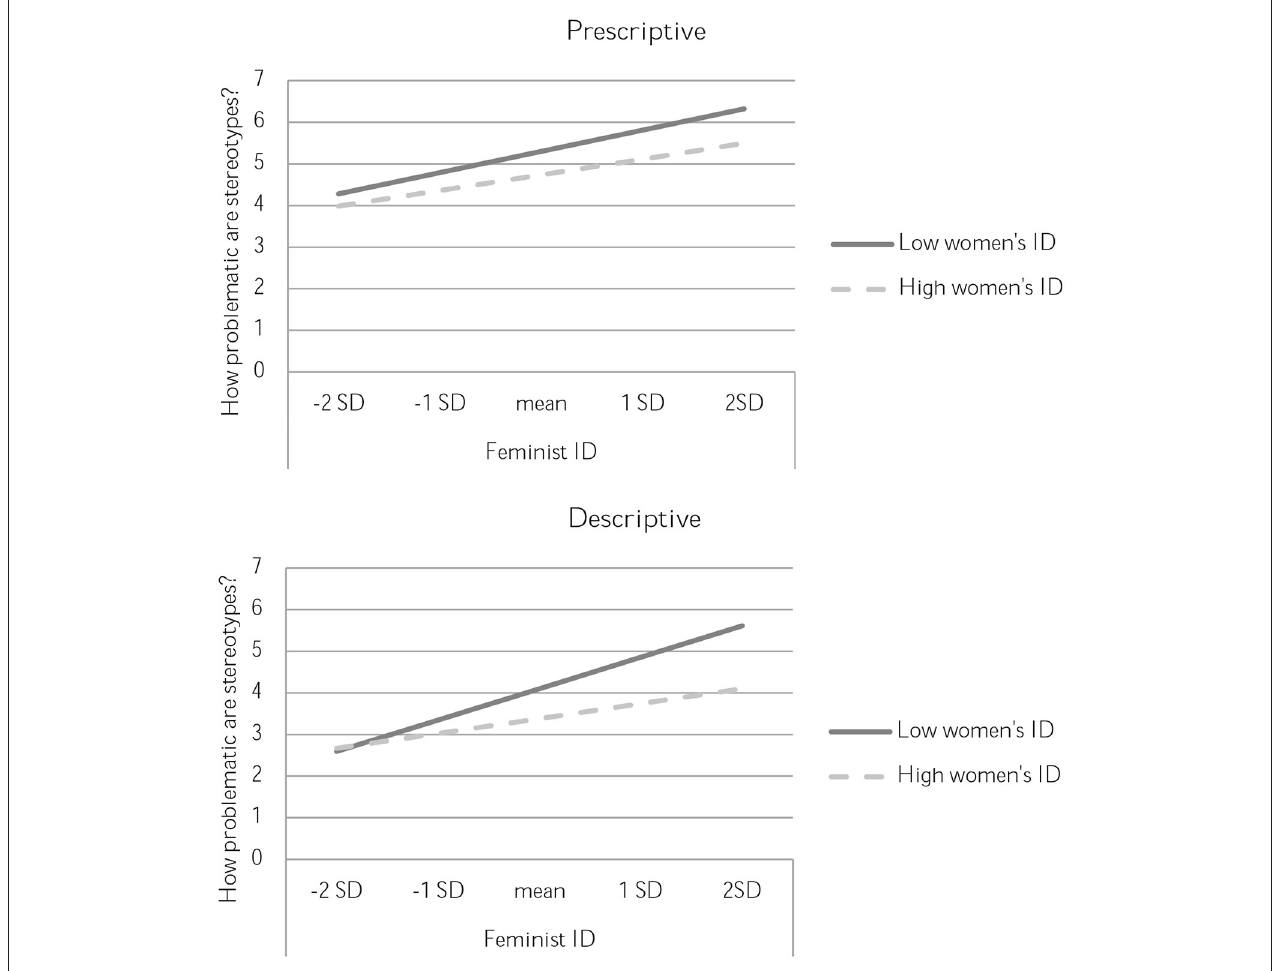
FIGURE 1 | Perceptions of the problematic nature of stereotypes in Study 3, separated by prescriptive (top) vs. descriptive (bottom) phrasing. High and low women’ s identification are plotted at ± 1 standard deviation from the mean.